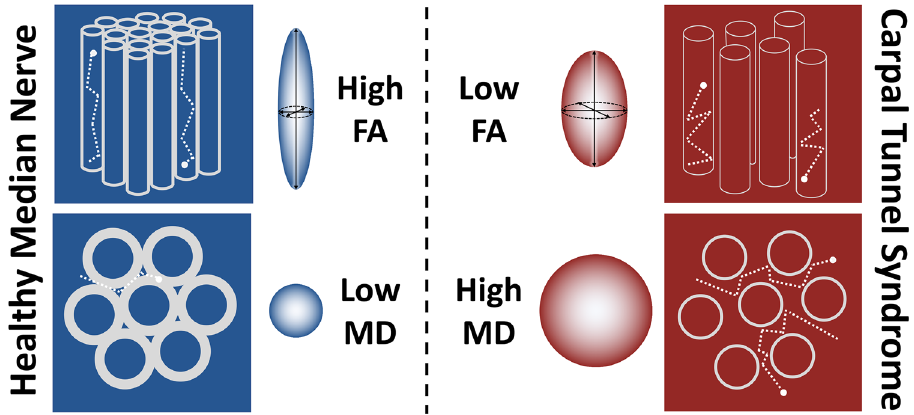
Figure 1. A diagram of nerve fibres (top) and in cross-section (bottom) demonstrating how diffusion tensor imaging metrics change in CTS. In healthy nerves, the axons are enveloped by myelin sheaths and arranged relatively tightly, which restricts the diffusion of water to the long axis of the nerve. Chronic compression leads to distortion of the axonal architecture, demyelination and as such, degradation of physiological barriers to the diffusion of water diffusion. Consequently, more diffusion occurs perpendicular to the long axis of the nerve as water is more free to diffuse around the fibres, reducing the factional anisotropy (FA) and increasing the magnitude of diffusion (mean diffusivity,